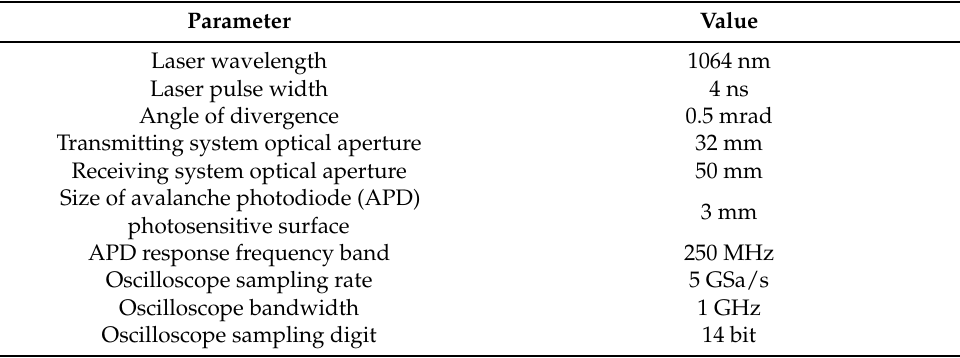
Table 1. Specifications of the experimental instrument.